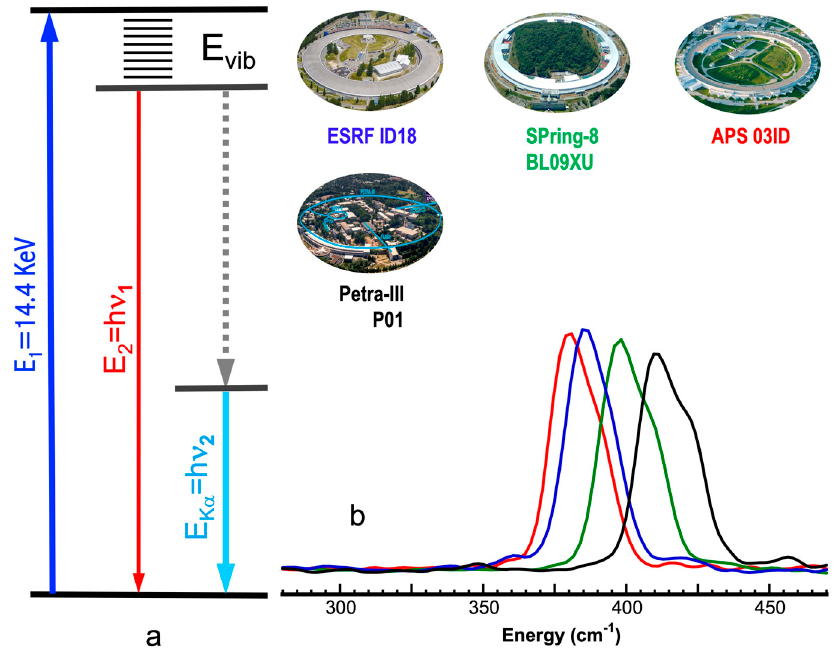
Figure 1. ( a ) An illustrative energy diagram for NRVS transitions; ( b ) the uncalibrated NRVS spectra for (NEt 4 )[FeCl 4 ] measured at four NRS beamlines around the world: APS 03ID (red), ESRF ID18 (blue); SPring-8 BL09XU (green), and Petra–III P01 (black). The top inserts in ( b ) are the overviews for the four SR centers.